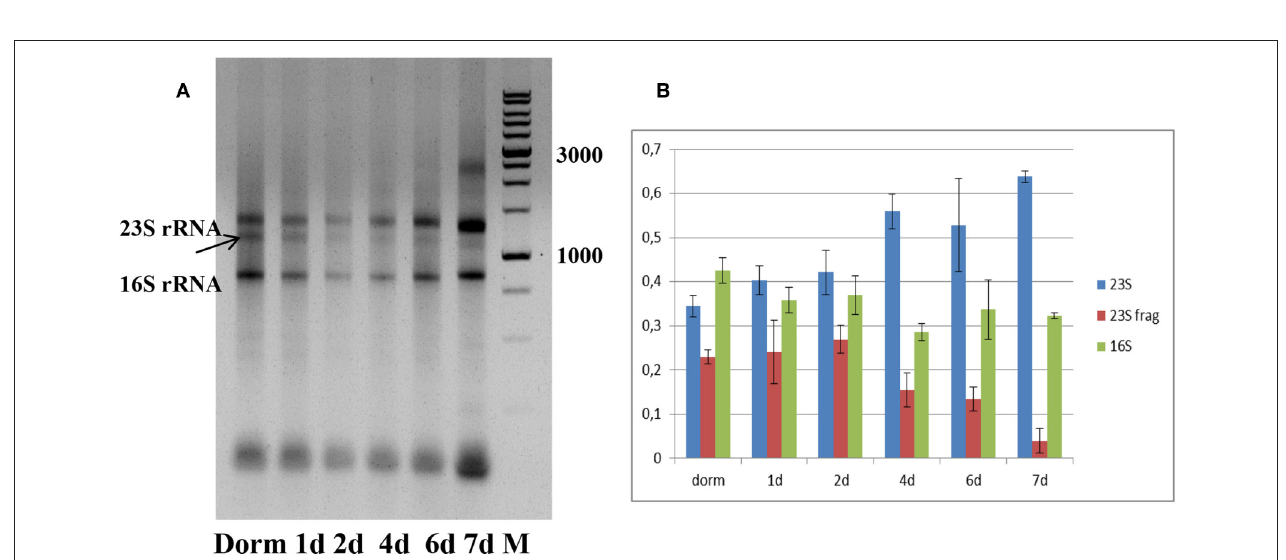
FIGURE 2 | Ribosomal RNA status during resuscitation. (A) 1.0% agarose gel profiling of total RNA samples. Arrow indicates the 23S rRNA fragment characteristic for M. tuberculosis NC state. M − 1kb DNA ladder (SibEnzyme, Russia). (B) Changes in the proportion of 23S/23S fragment/16S rRNAs in the process of resuscitation. The proportions obtained by image 2A processing by Gel-Pro Analyzer software. The results of three independent RNA isolation experiments were